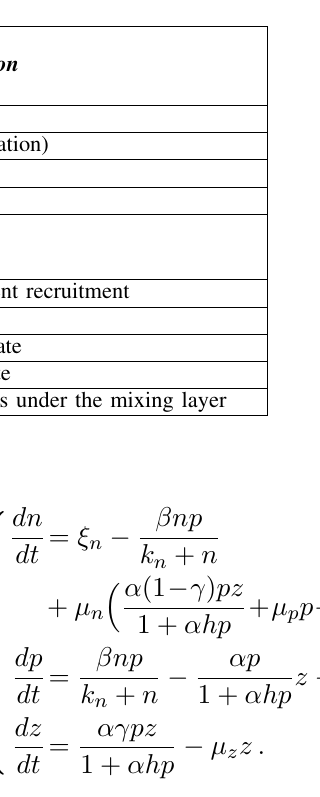
TABLE I: Parameters description of